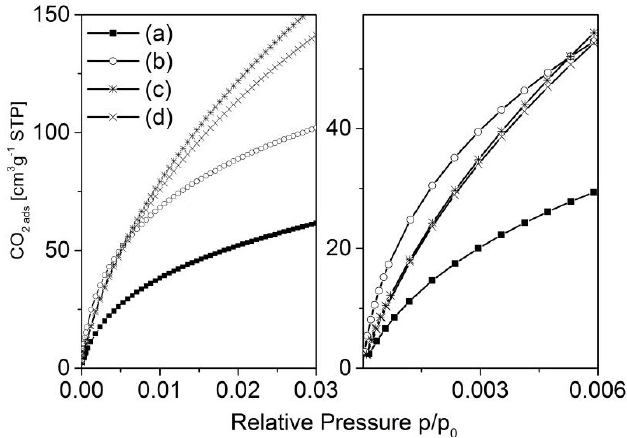
8 of 13 Figure 7. Ratio of micropore volume to total pore volume (micropore fraction) in dependence on the concentration of the used activation agent: series 873- x (a) and series 1173- x (b). Carbon dioxide adsorption experiments have been carried out in order to investigate the narrow micropores of the carbons. For both investigated series, the activated carbons show an increase in adsorbed carbon dioxide compared with the corresponding blank samples. It is interesting that, in the region of very low relative pressure, the strongest increase in adsorption is observed for the samples activated with the lowest concentration of potassium hydroxide (Figures 8 and 9, right hand side). Here, with increasing concentration of potassium hydroxide, the amount of adsorbed carbon dioxide decreases. However, that situation changes at somewhat higher relative pressures of about 0.005 (series 873- x ) and about 0.01 (series 1173- x ), respectively. The isotherms cross each other and the amount of adsorbed carbon dioxide then correlates with the concentration of the activating agent.